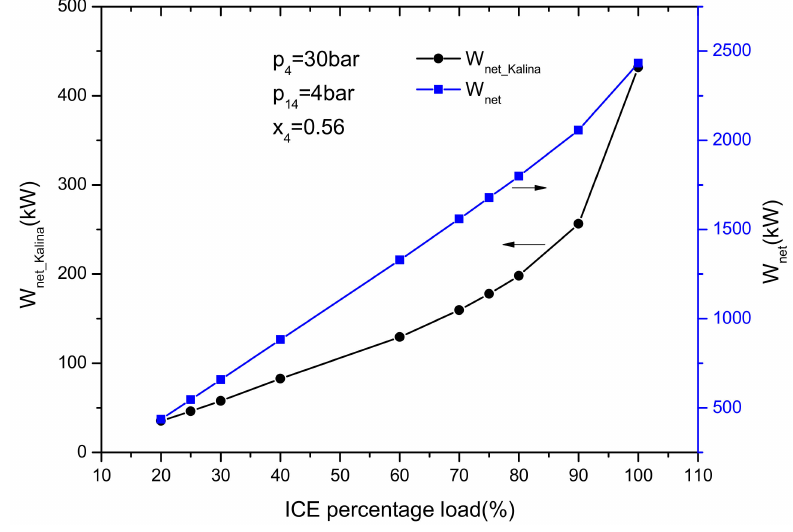
Figure 4. Effects of ICE percentage load on W net_Kalina and W net